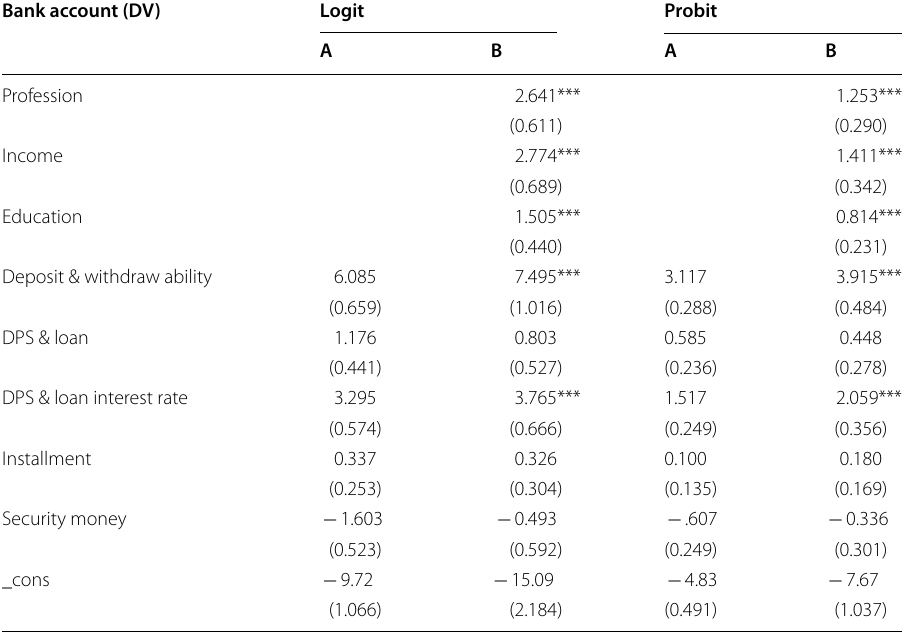
Table 6 Regression result of banking access and financial literacy. Source : Author’s